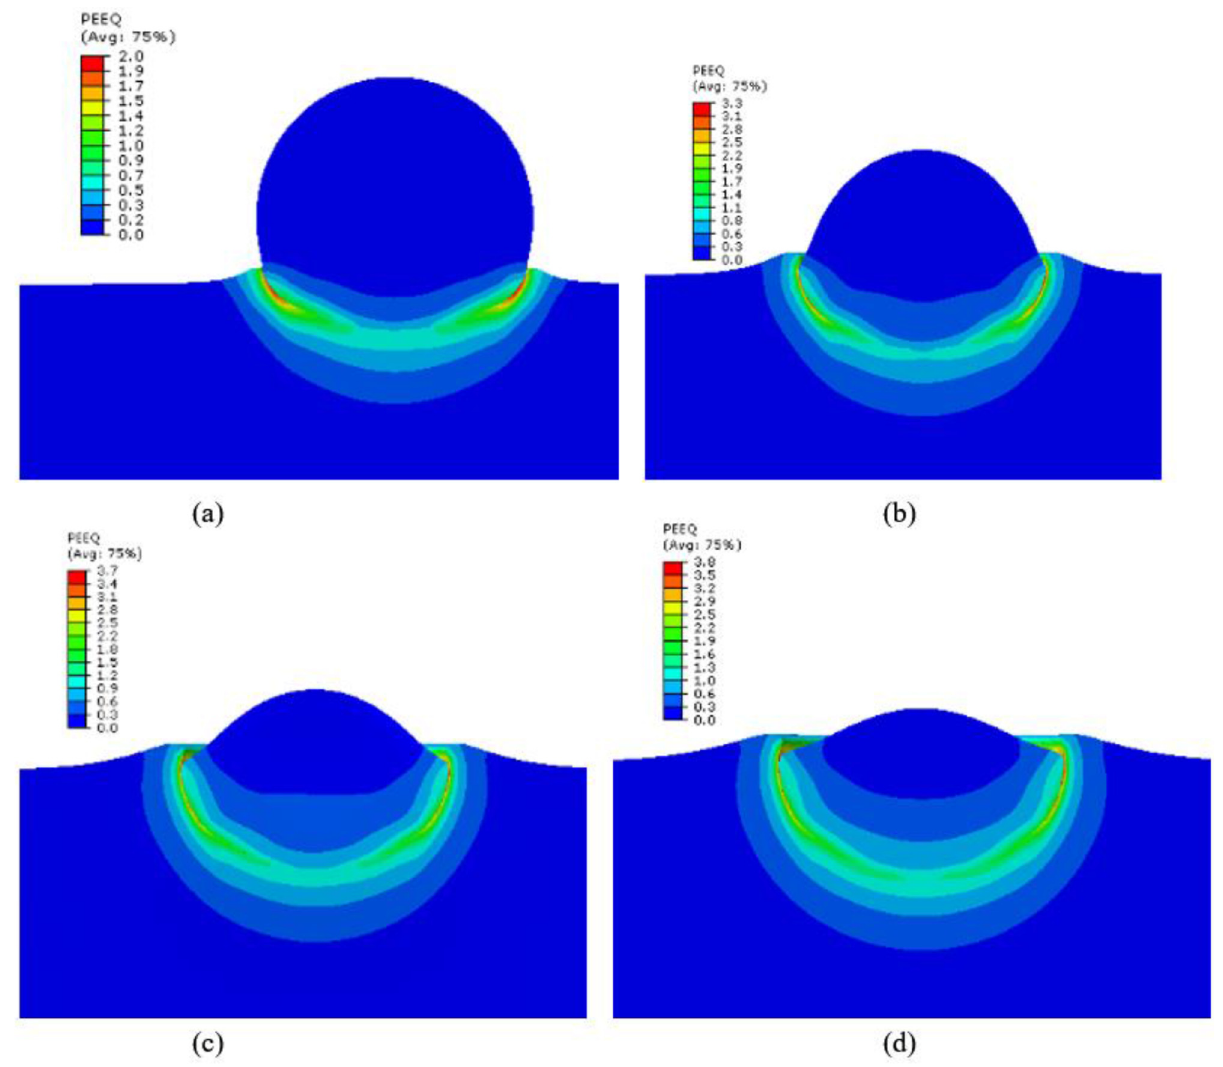
Fig. 2. Equivalent plastic strain time-evolution at 500m/s Cu/Al impact of (a) 5 ns (b) 10ns (c) 20ns (d) 30ns by using the Lagrangian numerical